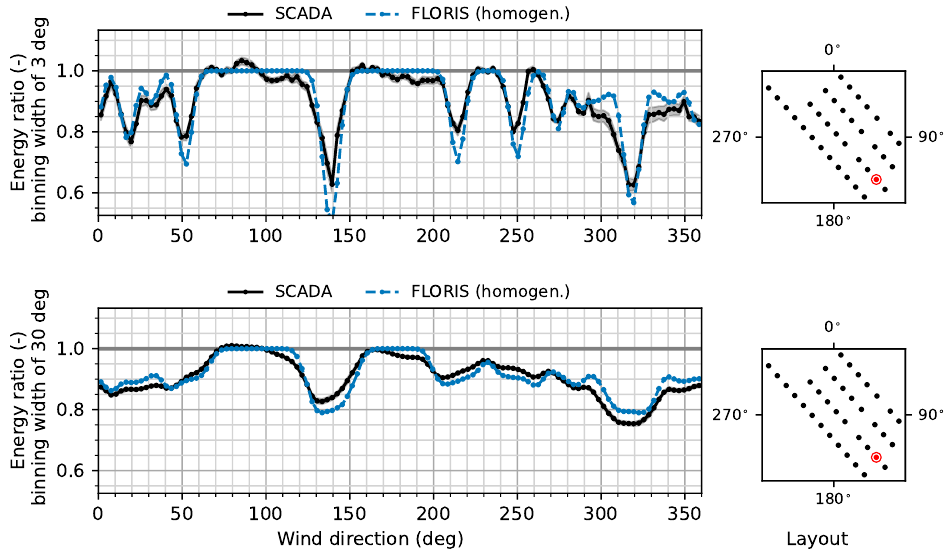
Figure 18. Energy ratio curves for Turbine 13 in the OWEZ wind farm, where the reference turbines are all upstream turbines within a 5 km radius, and the reference wind direction is the average of the nacelle headings of Turbines 0, 1, 15, and 22. The shaded regions represent 90% confidence intervals obtained through bootstrapping. The layout schematic on the right shows the location of Turbine 13 in the wind farm.